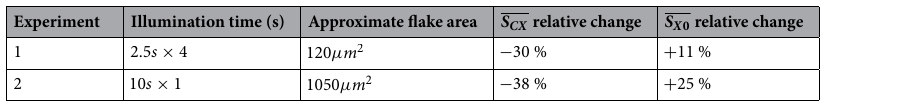
Table 1. Comparison of the results from the two homogenisation experiments. The relative changes in S CX and S X 0 are computed from the averages of all pixels taken from the before- and after-illumination PL maps for experiment 2 and t = 0 s and t = 10 s PL maps for experiment